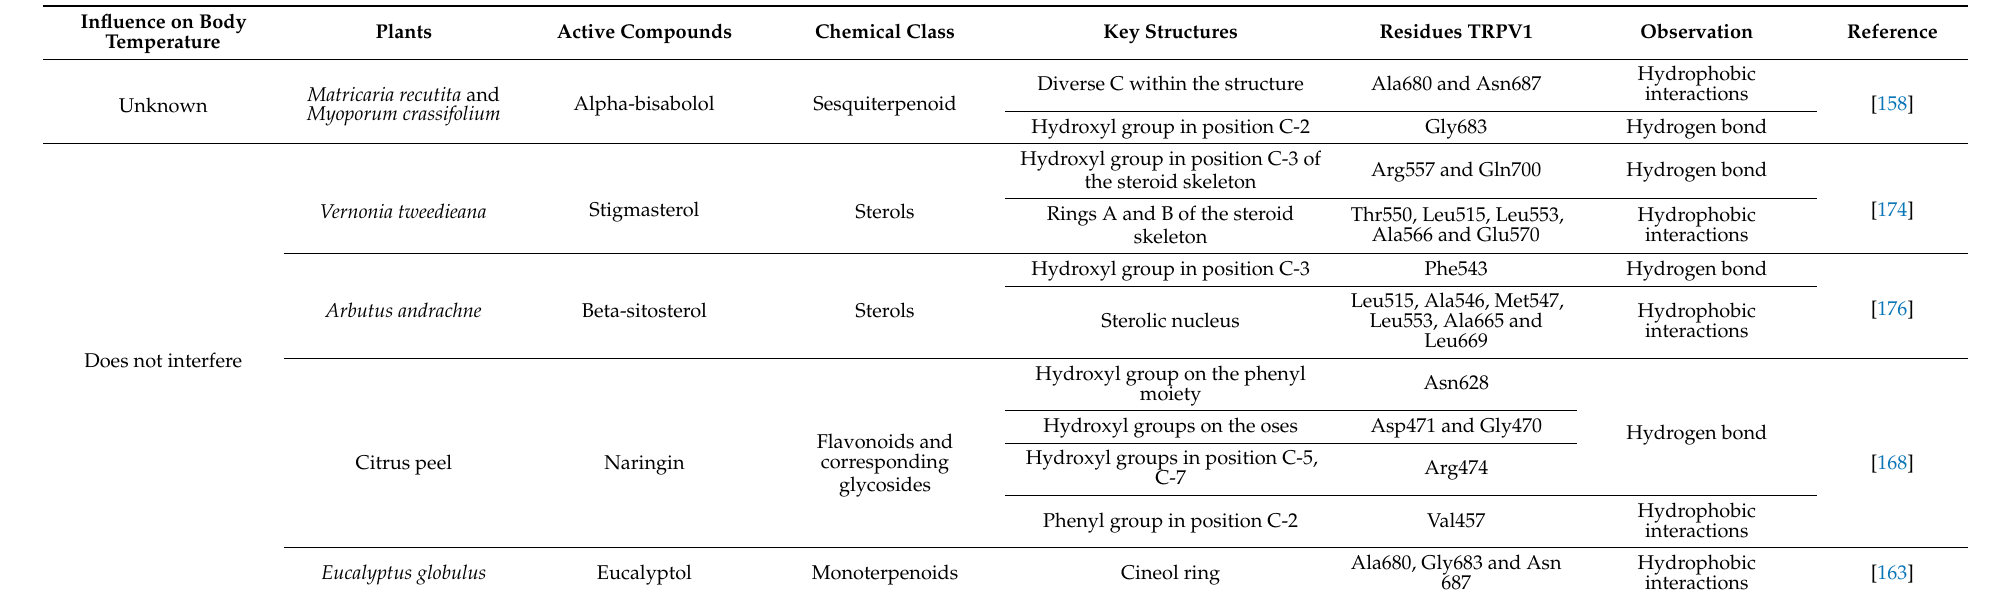
Table 2. Main interactions of TRPV1